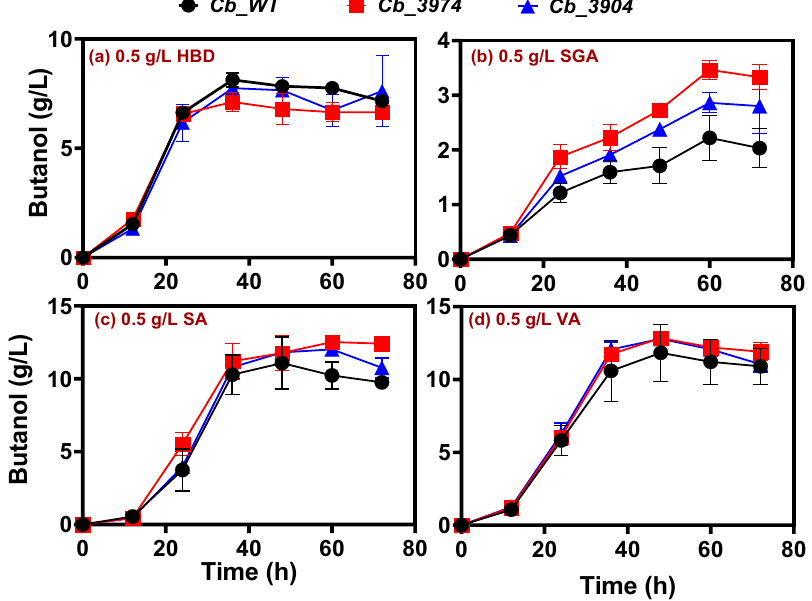
Figure 7. Butanol concentrations produced Cb _3974, _3904, and _wild type during ABE fermentation supplemented with 0.5 g/L 4-hydroxybenzaldehyde (4-HBD), syringaldehyde (SGA), syringic acid (SA), and vanillic acid (VA).